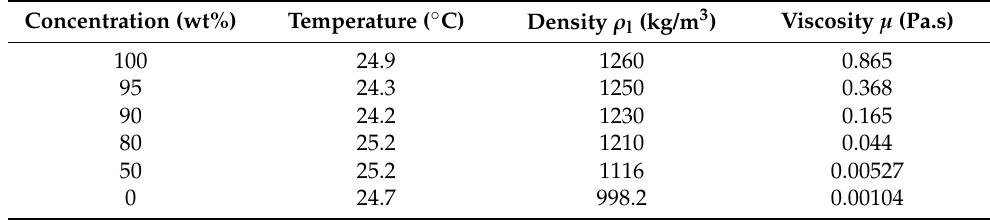
Table 2. Rheological test results of glycerol aqueous solution used in the experiment. Concentration (wt%) Temperature (°C) Density ρ l (kg/m3)